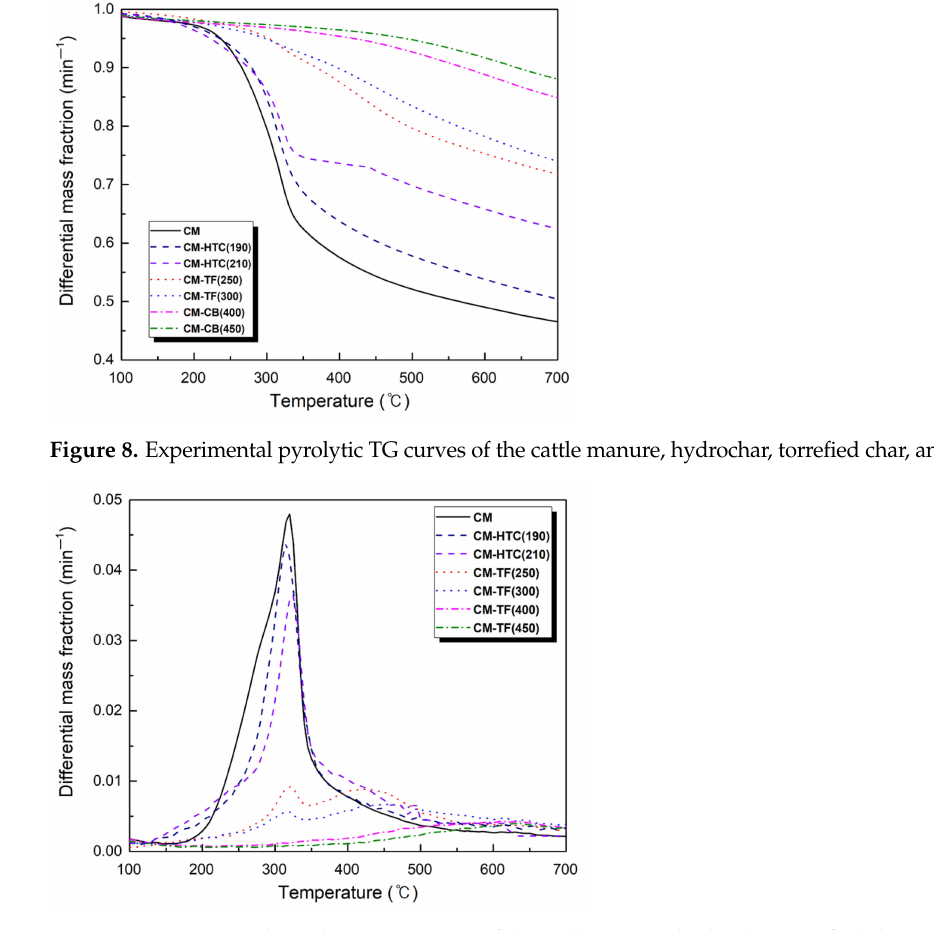
Figure 9. Experimental pyrolytic DTG curves of the cattle manure, hydrochar, torrefied char, and biochar. Table 4. Characteristics of the cattle manure, hydrochar, torrefied char, and biochar during pyrolysis.